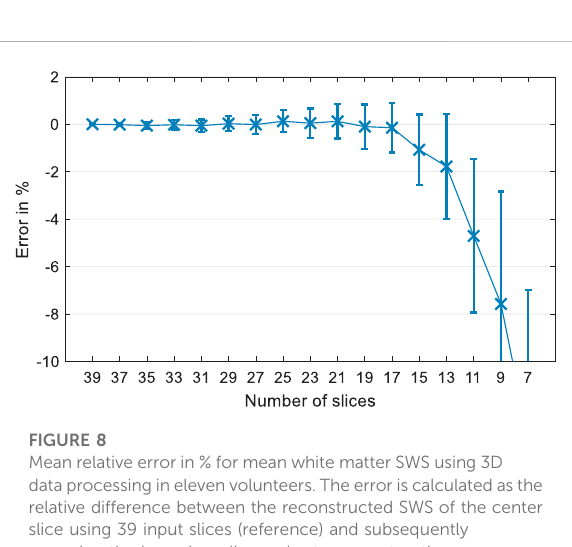
FIGURE 8 Mean relative error in % for mean white matter SWS using 3D data processing in eleven volunteers. The error is calculated as the relative difference between the reconstructed SWS of the center slice using 39 input slices (reference) and subsequently removing the boundary slices prior to reconstruction.